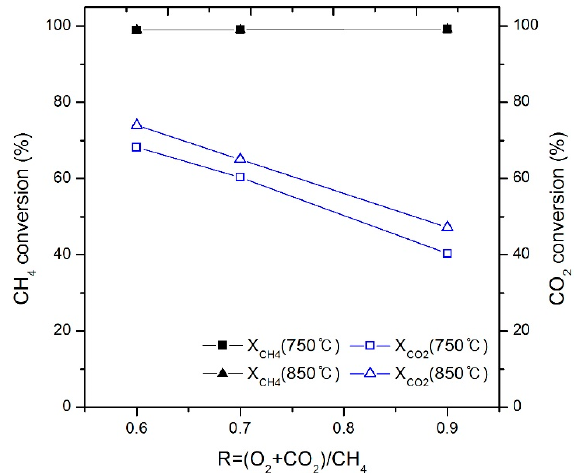
Figure 11. Effect of R = ((O 2 + CO 2 )/CH 4 ) values on H 2 and CO formation with steam addition.